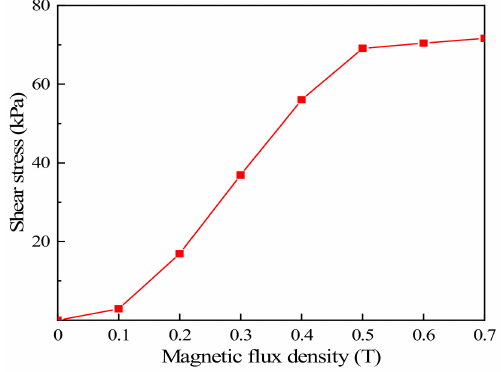
Figure 5. τ y –B curve of MRF-J01T.